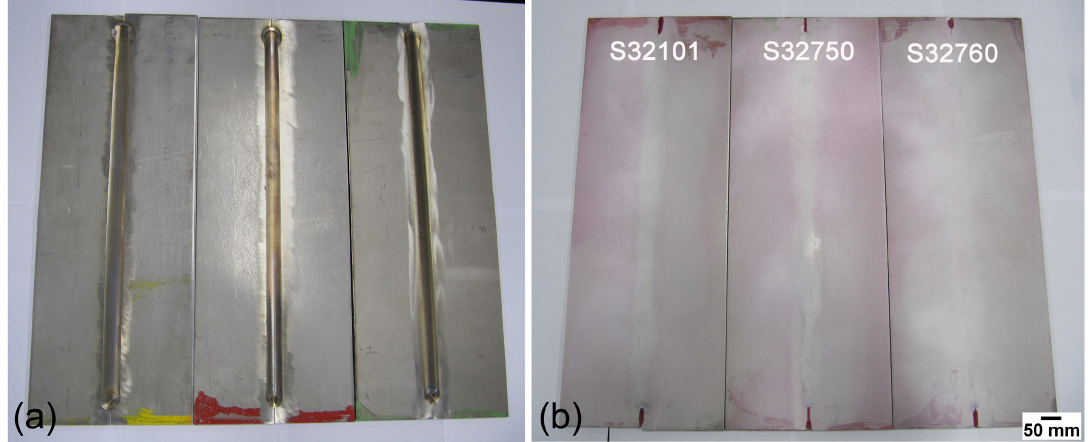
Fig. 5. Welded joints of UNS S32101, S32750, and S32760 DSS: (a) face, (b) root submitted to liquid penetrant test.